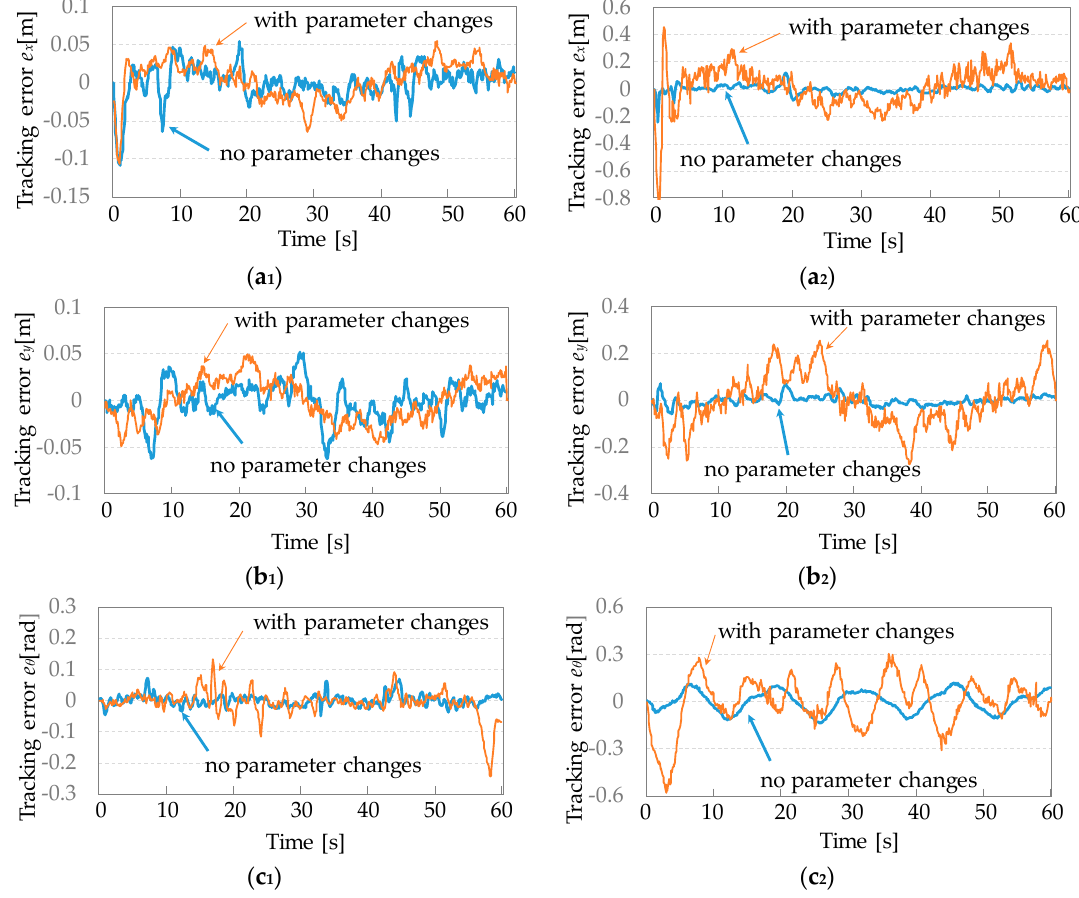
Figure 13. Trajectory tracking errors (with robust compensation: ( a 1 ) x position; ( b 1 ) y position; and ( c 1 ) orientation θ ) (non ‐ robust compensation: ( a 2 ) x position; ( b 2 ) y position ( c 2 ); and orientation θ ).